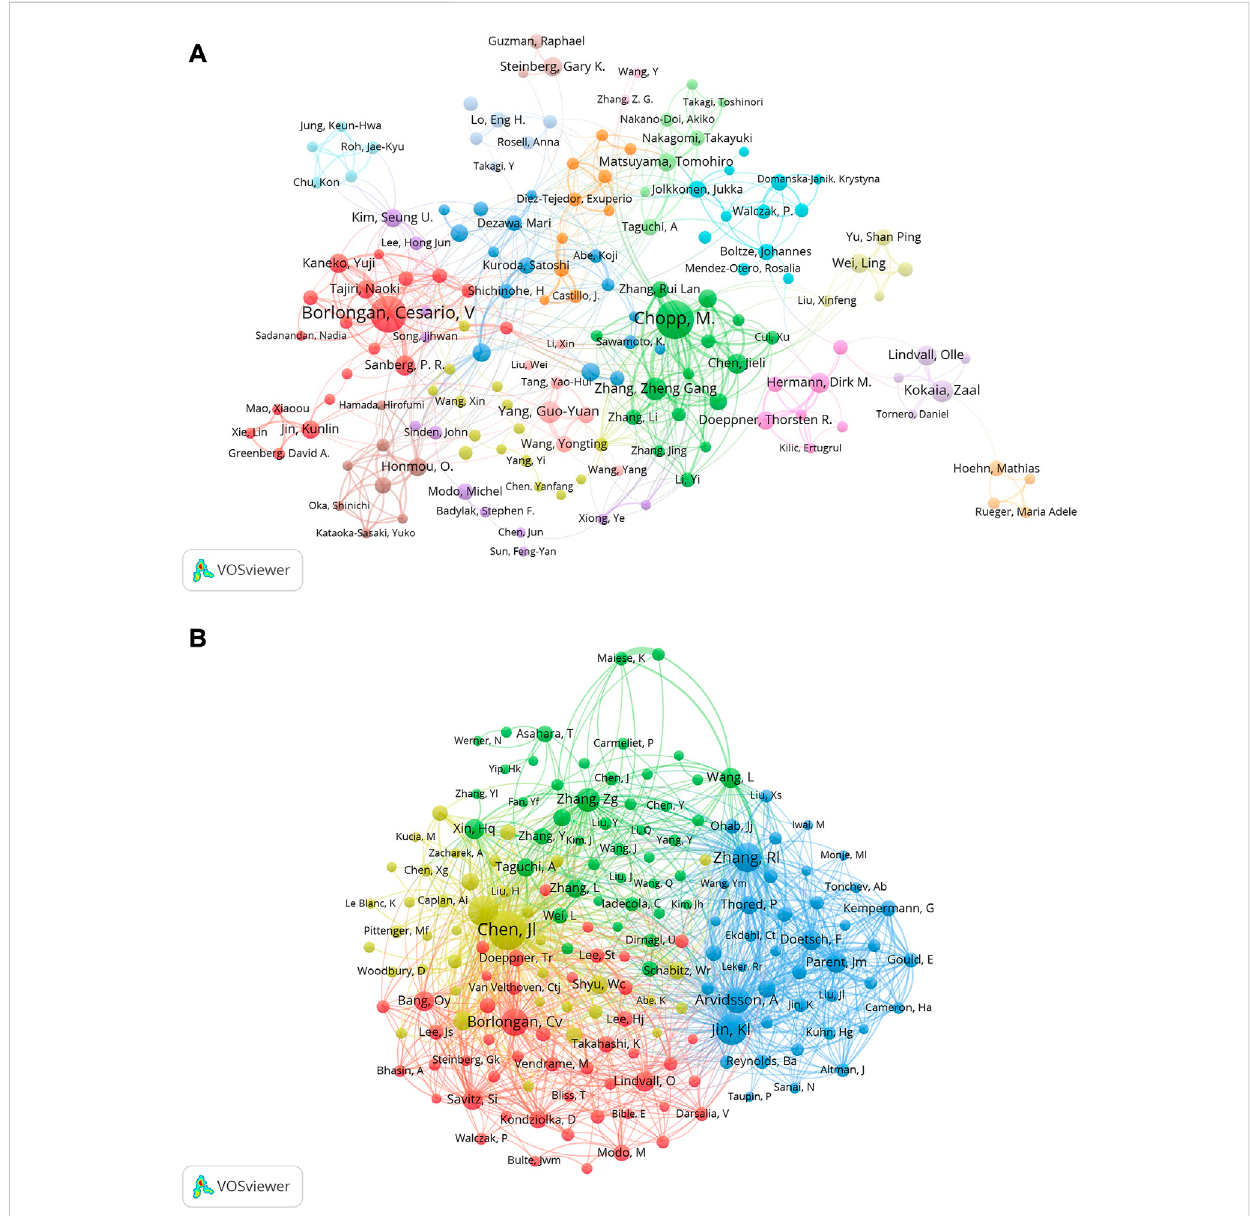
FIGURE 5 (A) Co-authorrelatedtostemcellsinstroke.Eachcirclerepresentsanauthor,thelinesbetweenthecirclessignifyconnectionsbetweentheauthors, and the networks of connections in different colors signify cooperative clusters among different authors (B) Co-cited-author clustering